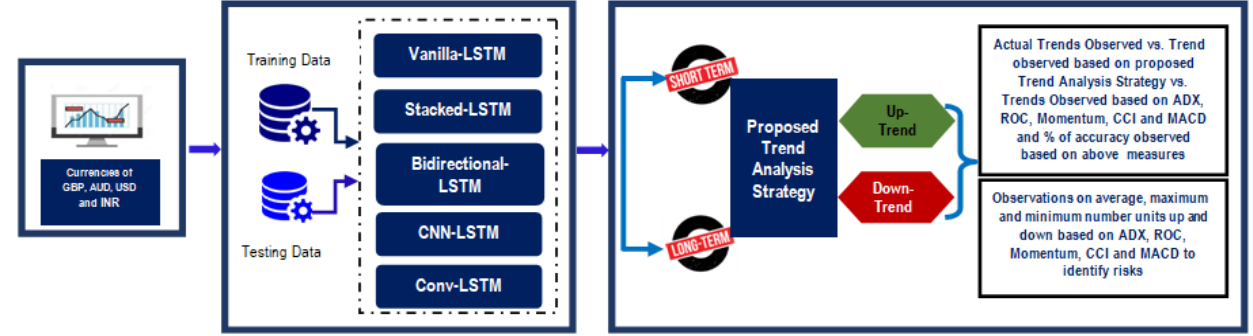
Figure 2. Schematic layout of the proposed trade and trend analysis model.